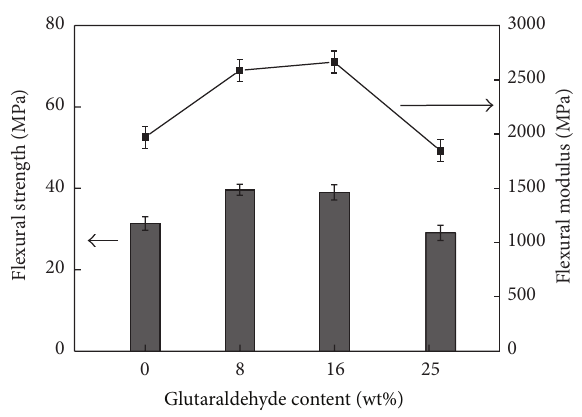
Figure 14: Flexural properties of the kenaf/SPI-PVA composites with GA content.